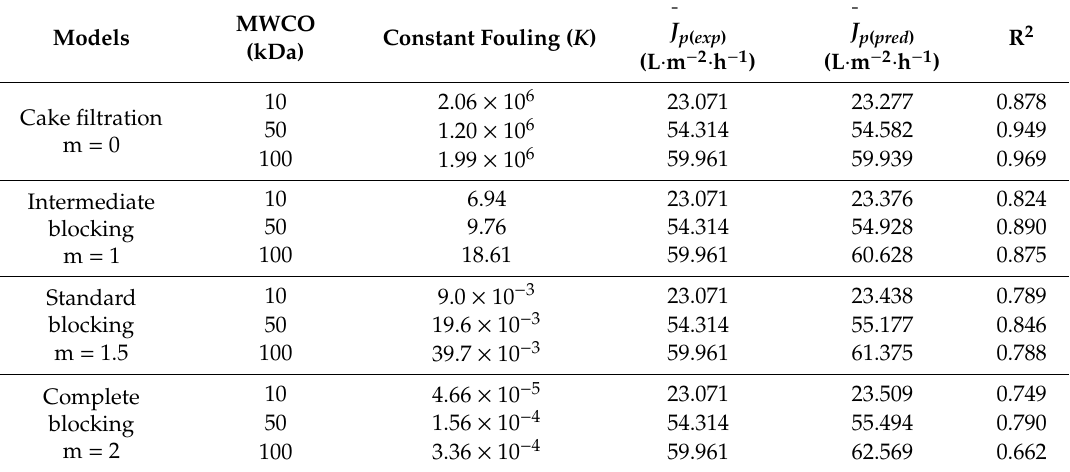
Figure 4. Specific resistance ( α ) and fouling resistance ( R f ) calculated using the resistance-in series-model for ( a ) 10 kDa molecular weight cut-off (MWCO), ( b ) 50 kDa MWCO, and ( c ) 100 kDa MWCO membranes. Table 5. Values of pore-blocking parameters, comparison between the experimental and predicted average permeate flux, and the model fitting accuracy (R 2